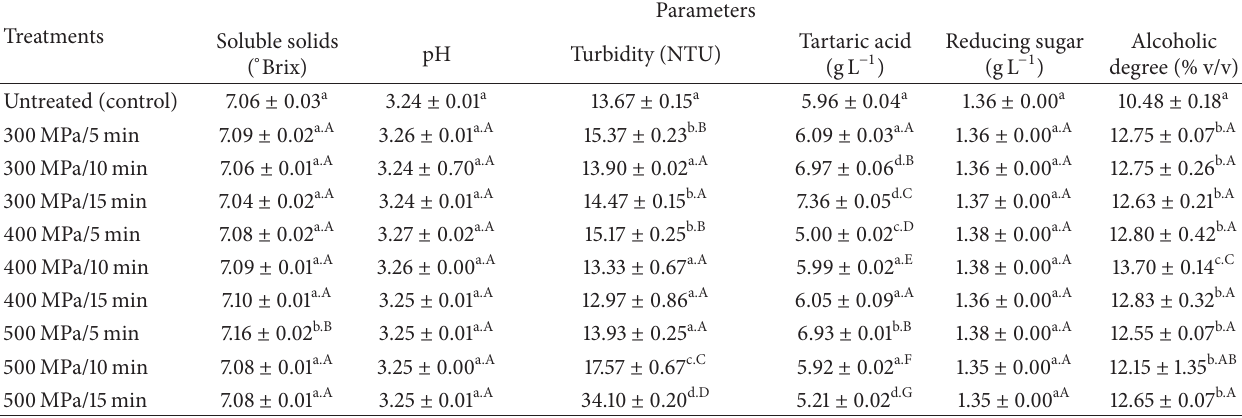
Table 2: Effects of HHP on physicochemical parameters.